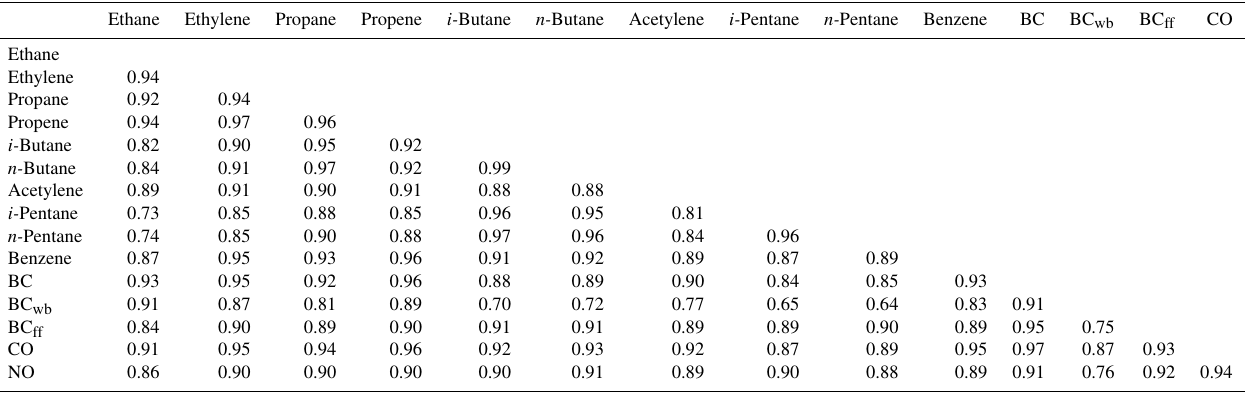
Table 3. Correlation coefficients ( R 2 ) of NMHCs and major gaseous pollutants for the total period of measurements (all significant at p < 0 . 01).